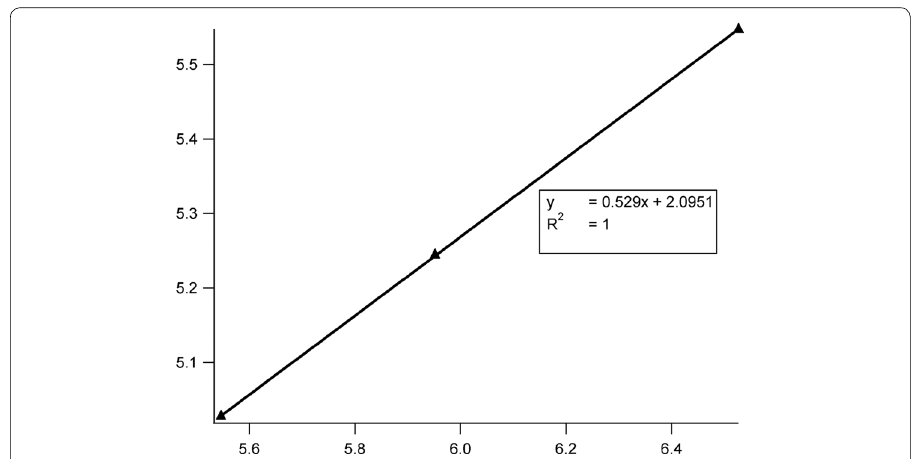
Fig. 5 Regression linear of dimensionless variable to calculate values for a and